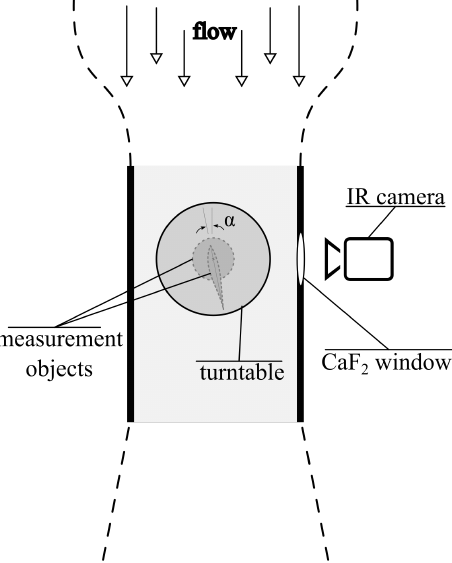
Figure 4. Experimental setup in the wind tunnel. The thermographic camera ImageIR 8300 watches the cylinder measurement object through a CaF 2 -window. Additional camera systems observe the test section of the wind